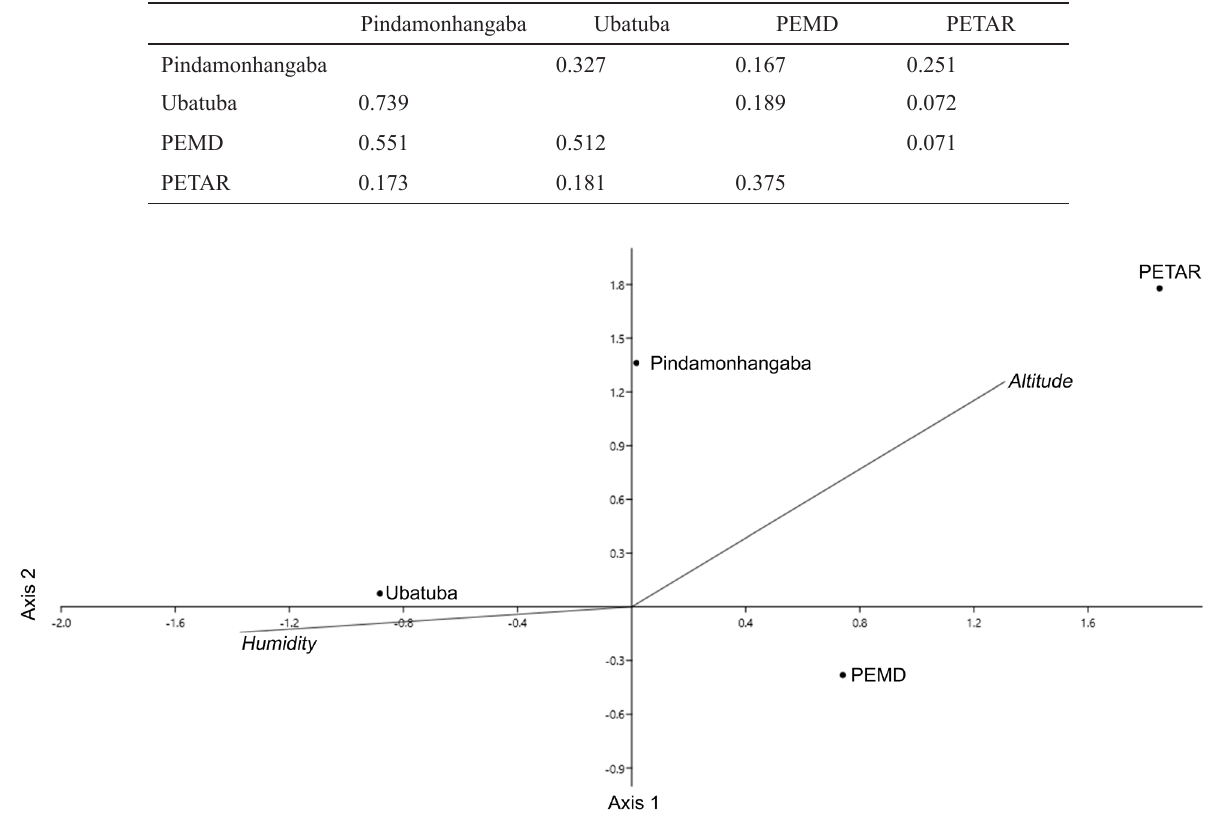
Table 3. Sørensen index (bottom of the table) and Bray–Curtis index (top of the table) for the four study areas. PEMD: Parque Estadual Morro do Diabo; PETAR: Parque Estadual Turístico do Alto Ribeira.